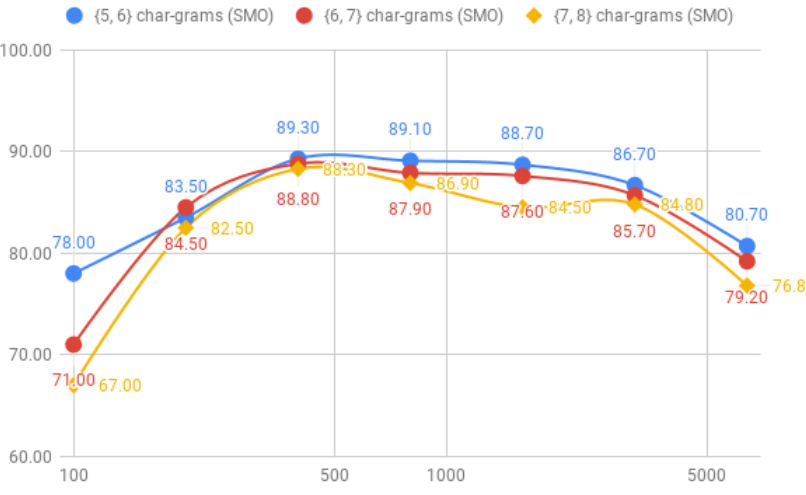
Figure 11. Comparison of the accuracy between {5, 6}, {6, 7}, {7, 8} char-grams for the SMO